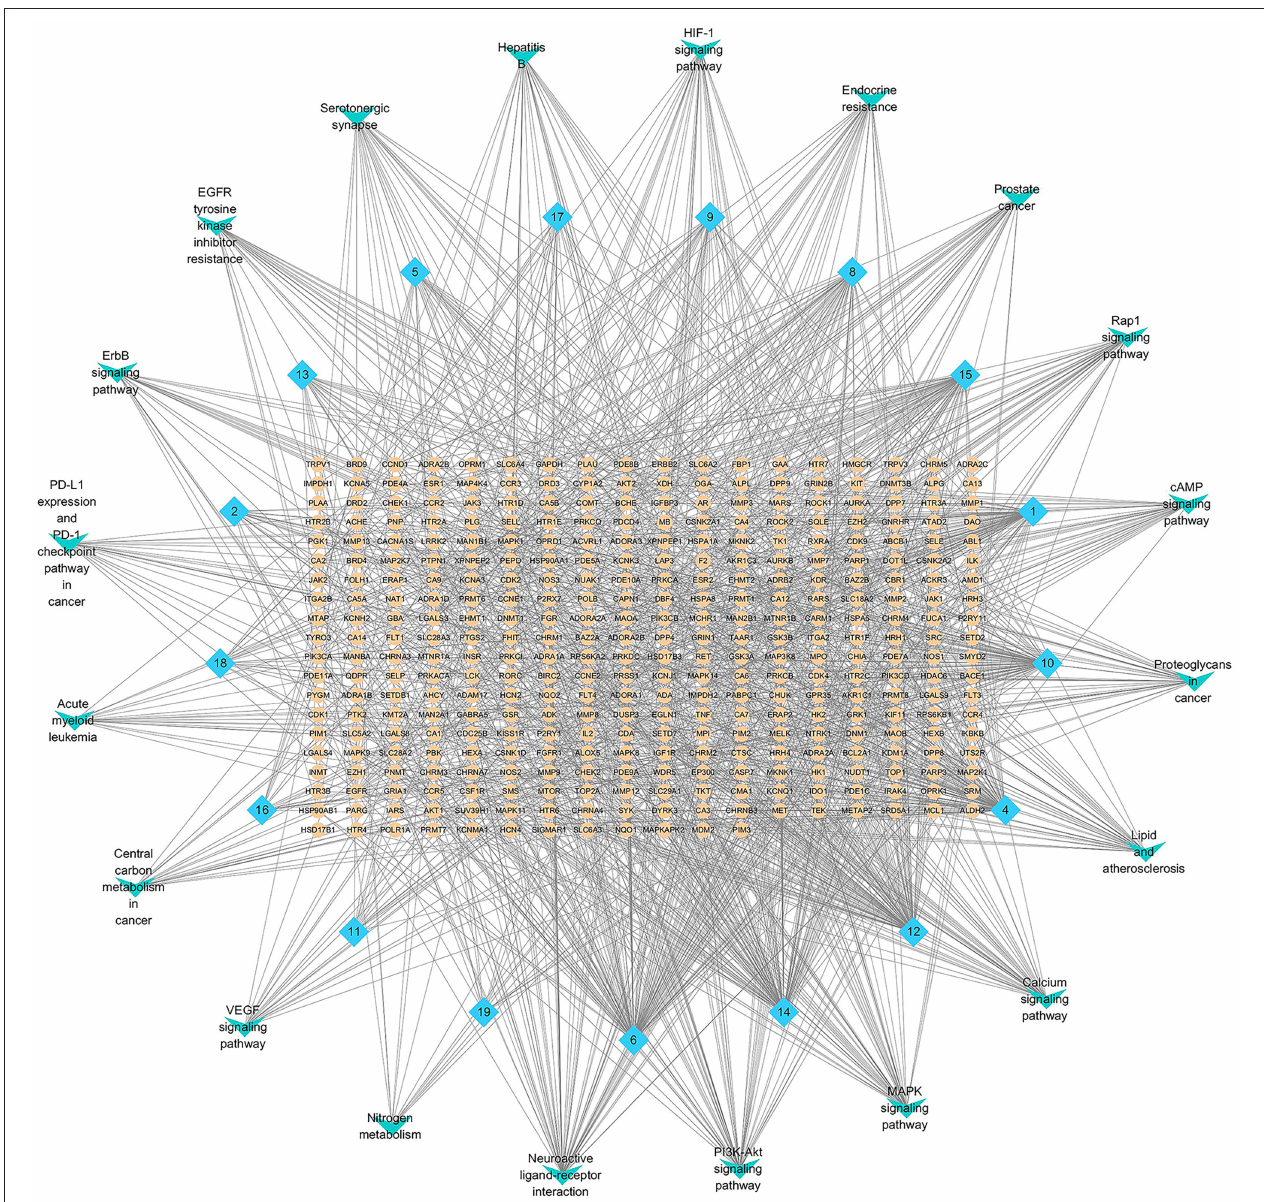
FIGURE 7 | Network pharmacology analysis of difference metabolites in A. tanguticus. (Blue is the compound, yellow is the target of the compound, green is the top 20 prominent